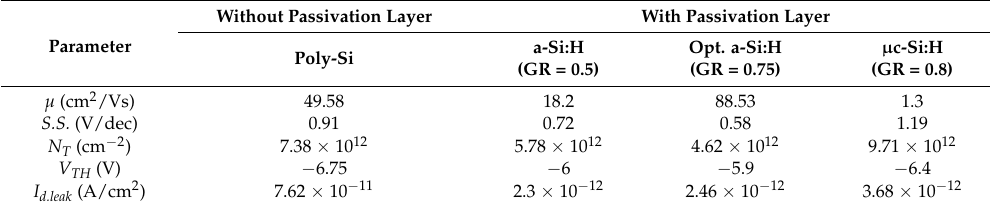
Figure 3. Transfer characteristics of low temperature poly-Si thin film transistors (LTPS TFTs) with and without passivation layers. The inset figure shows the defect states in the LTPS TFTs simulated by technology computer-aided design (TCAD). Table 1. Comparison of electrical characteristics of p-channel LTPS TFTs with and without passivation layers on glass substrates.